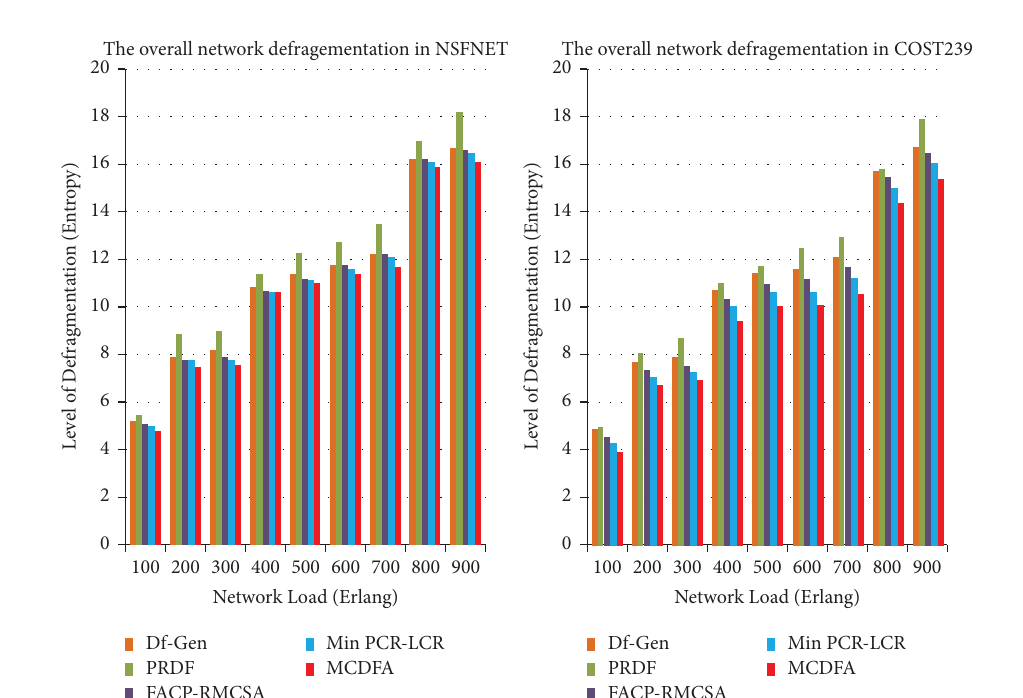
Figure 11: Te overall network defragmentation (entropy) for NSFET and